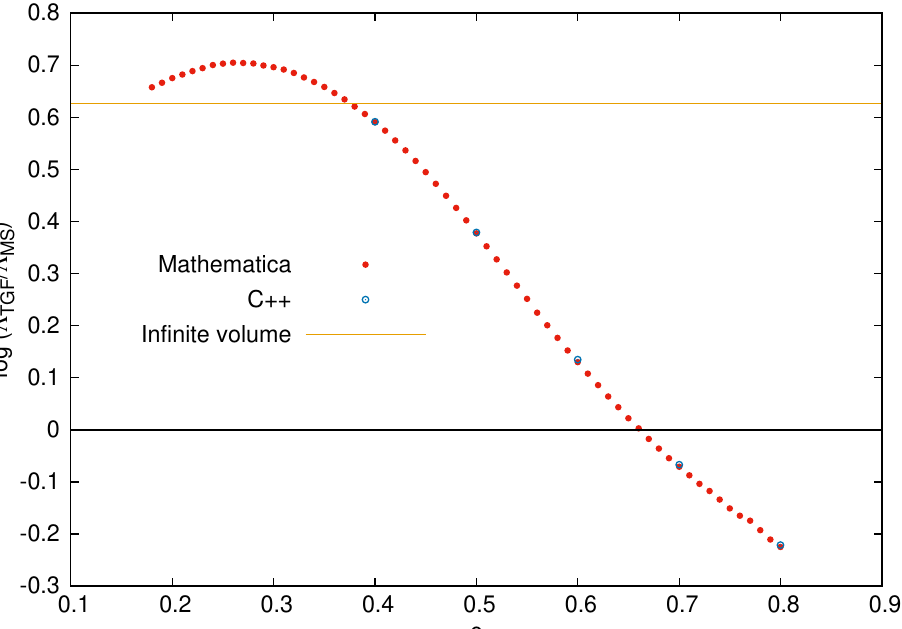
Figure 1. We display log((cid:3) TGF = (cid:3)